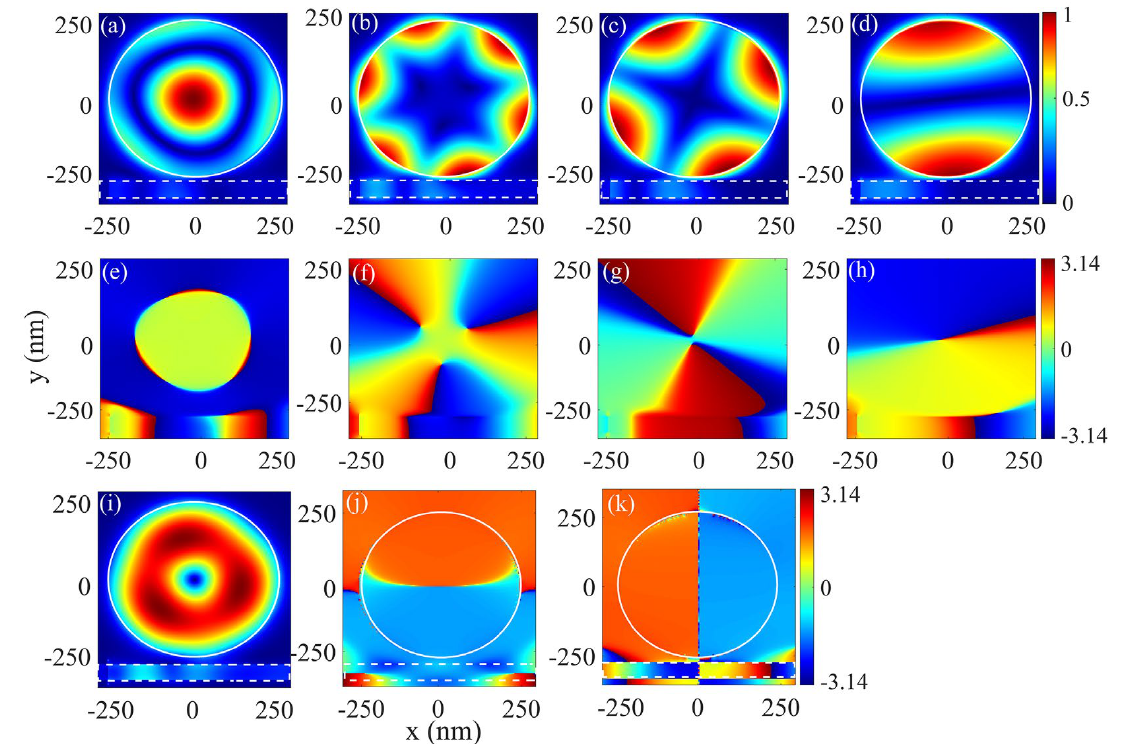
Figure 2. The magnetic and electric field distributions for four dips. For dip 1 at 449.1 nm, the distributions of ( a ) the magnetic field module ( | H | ) and ( e ) phases (P(H)). For dip 2 at 460.1 nm, the distributions of ( b ) | H | and ( f ) phases (P(H)). For dip 3 at 606.2 nm, the distributions of ( c ) | H | and ( g ) phases (P(H)). For dip 4 at 969.2 nm, the distributions of ( d ) | H | and ( h ) phases (P(H)). For dip 1 at 449.1 nm, the distributions of ( i ) the electric field module ( | E | ) and ( j ) E x , and ( k ) E y